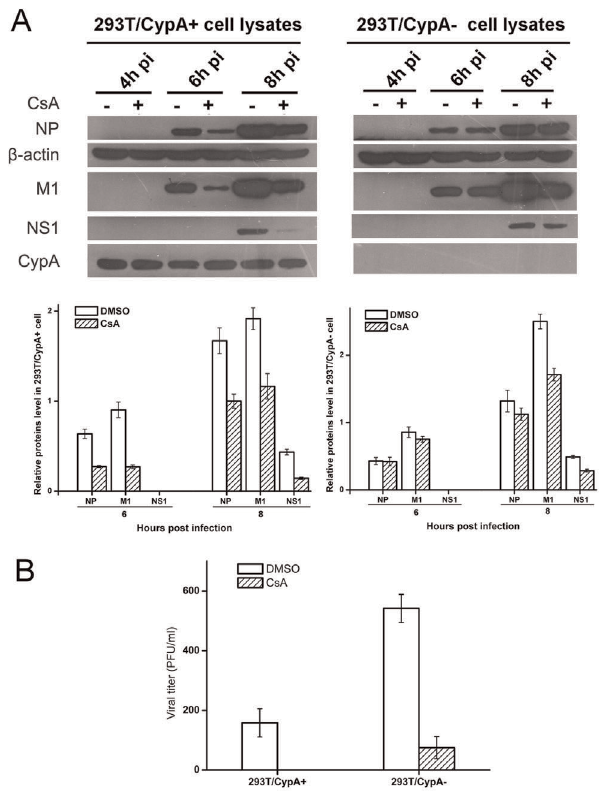
Figure 3. CsA selectively inhibited the viral proteins levels in both 293T/CypA + and 293T/CypA 2 cells. Both cell lines were infected with inuenza A/WSN/33 at MOI 1. After being washed with PBS, the cells were cultured with fresh medium supplemented without or with CsA (5 m g/ml). At 4 h p.i., 6 h p.i. and 8 h p.i., the cell lysates were collected to detect the M1, NP and NS1 proteins. b -actin as an internal control was also detected by Western blot analysis (A). The relative viral protein levels of M1, NP and NS1 in both 293T/CypA + and 293T/CypA 2 cells were calculated by quantifying the results shown in panel (A). The viral titers were detected at 8 h p.i. in two cell lines (B). Data are means 6 SD of three separate experiments.